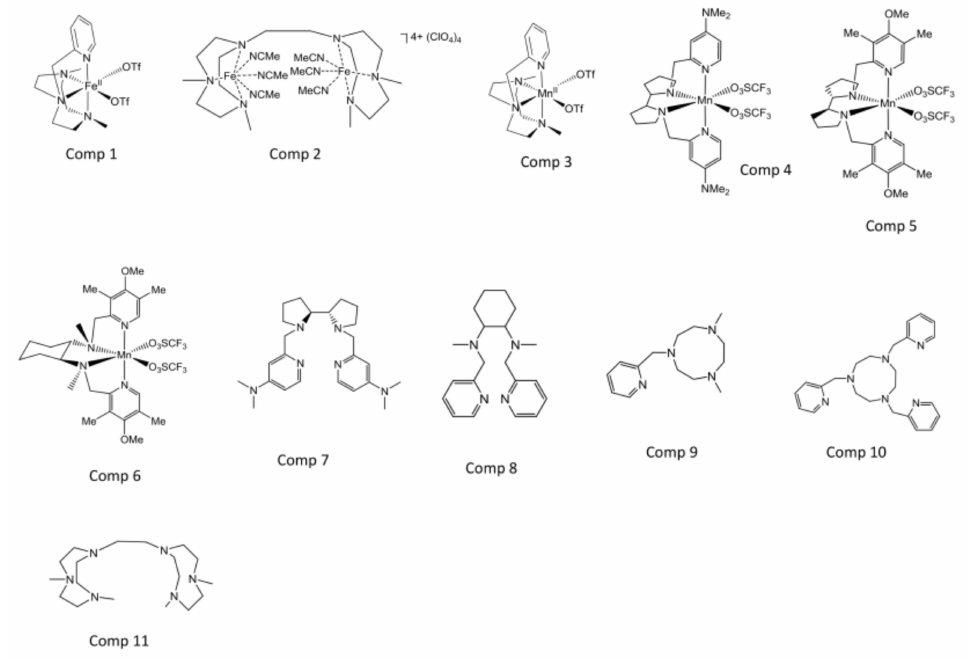
Figure 1. Chemical structure of the tested polyaminic compound